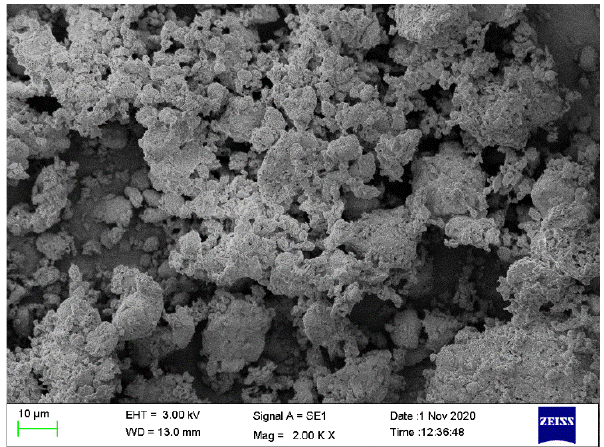
Figure 3. SEM image of raw gangue powders.